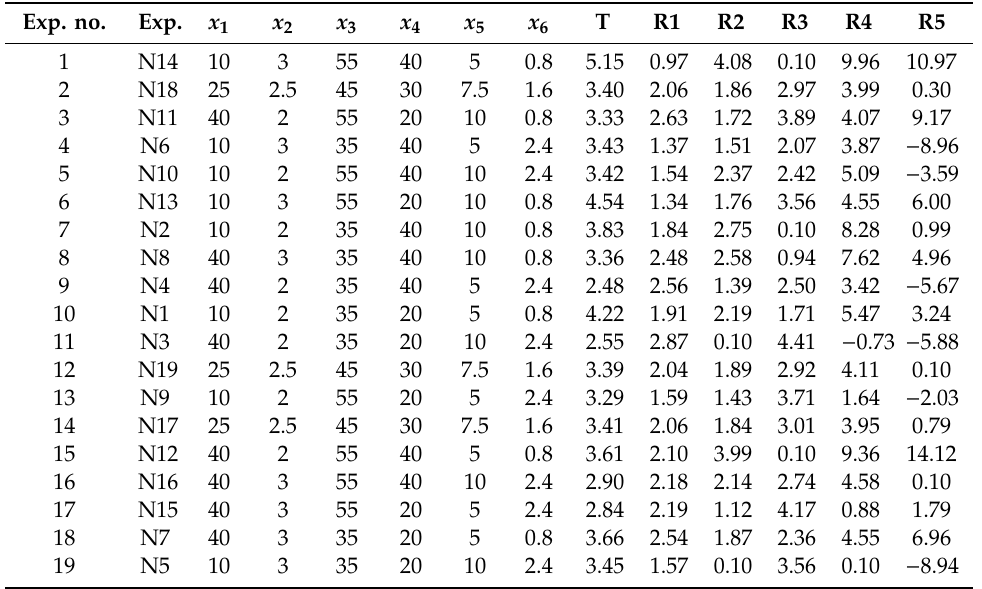
Table 1. Fractional factorial (resolution IV) design with the results of measured responses (CMAs). Exp. no.